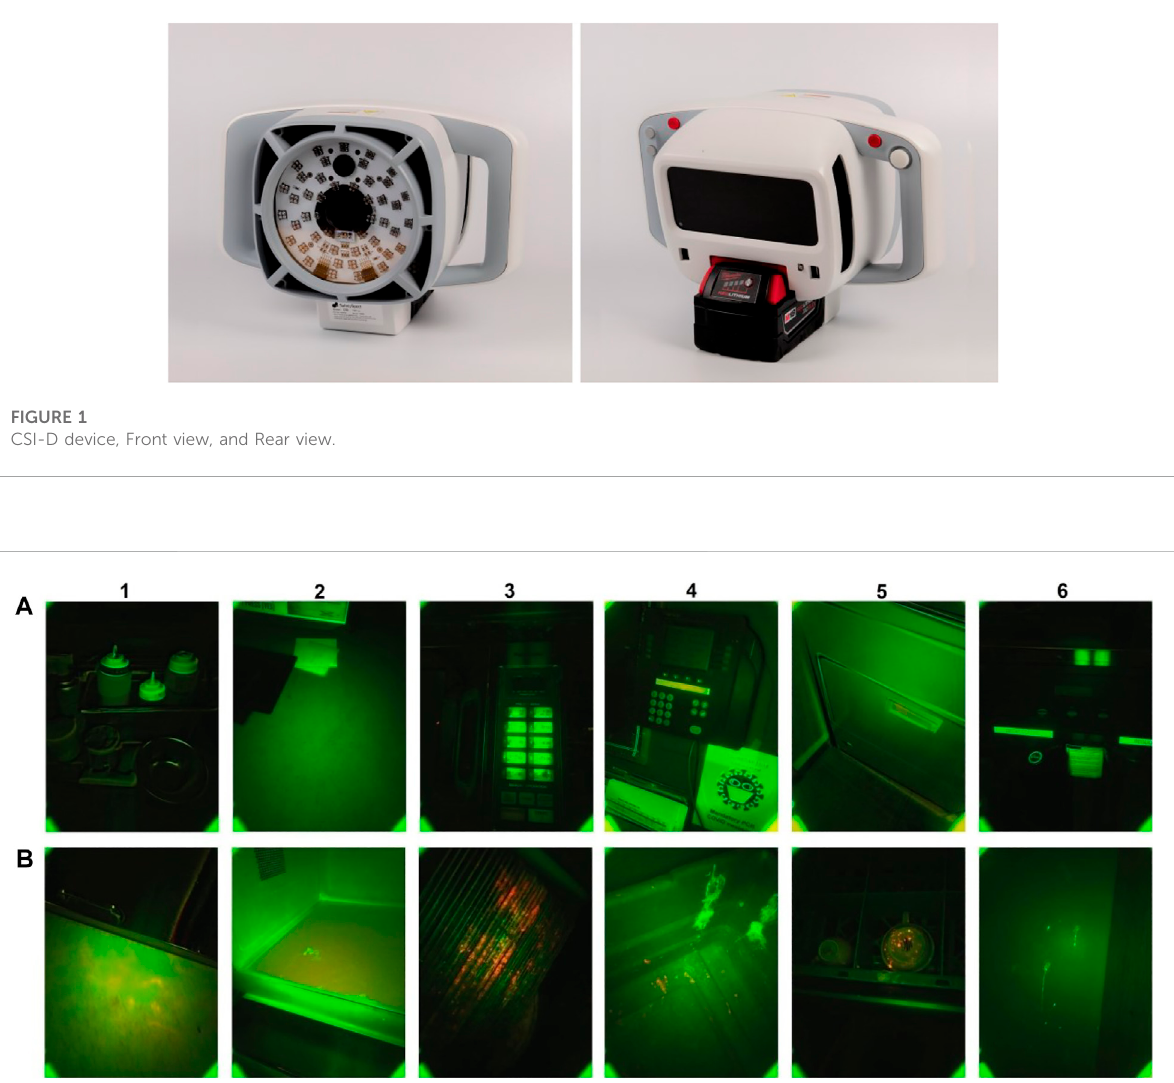
FIGURE 2 Fluorescence images captured by CSI-D (A) CSI-D fl uorescence images of surfaces without indications of contamination. (B) CSI-D fl uorescence images of surfaces with indications of contamination.